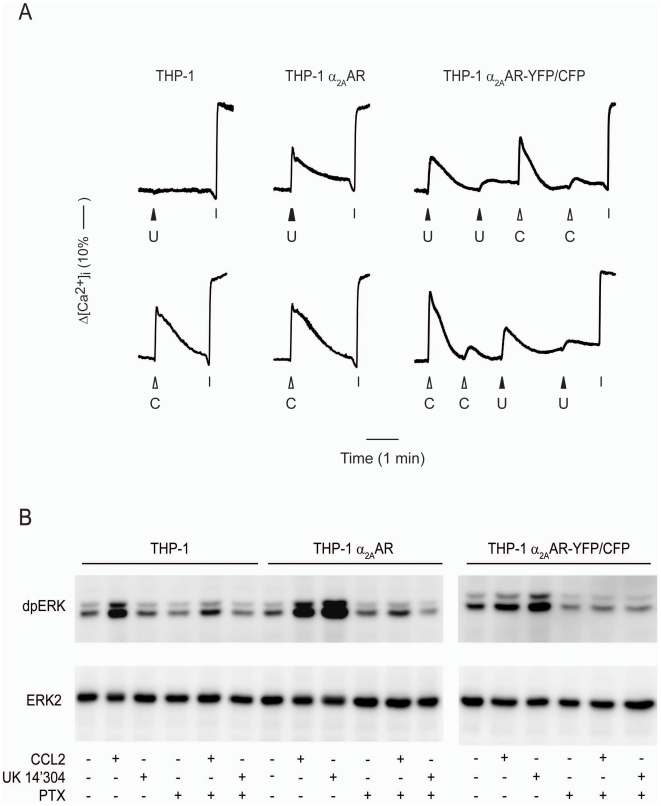
THP-1 cells-mediated signal transduction by endogenous and transfected receptors.(A) Intracellular calcium mobilization. Wild type and transfected THP-1 cells were loaded with Fura-2 and stimulated with 300 nM UK 14'304 (U) or 100 nM CCL2 (C). Fluorescence signals were normalized to maximum calcium influx elicited by the addition of ionomycin (I) as described in Methods. (B) Activation of ERK1/2 in THP-1 cells. Wild type and transfected THP-1 cells non-treated or pretreated with pertussis toxin (PTX) were stimulated for 2 min with 100 nM CCL2 or 300 nM UK14'304. Upper images are Western blots of dual phosphorylated ERK1 and 2, below total ERK2 (loading reference).